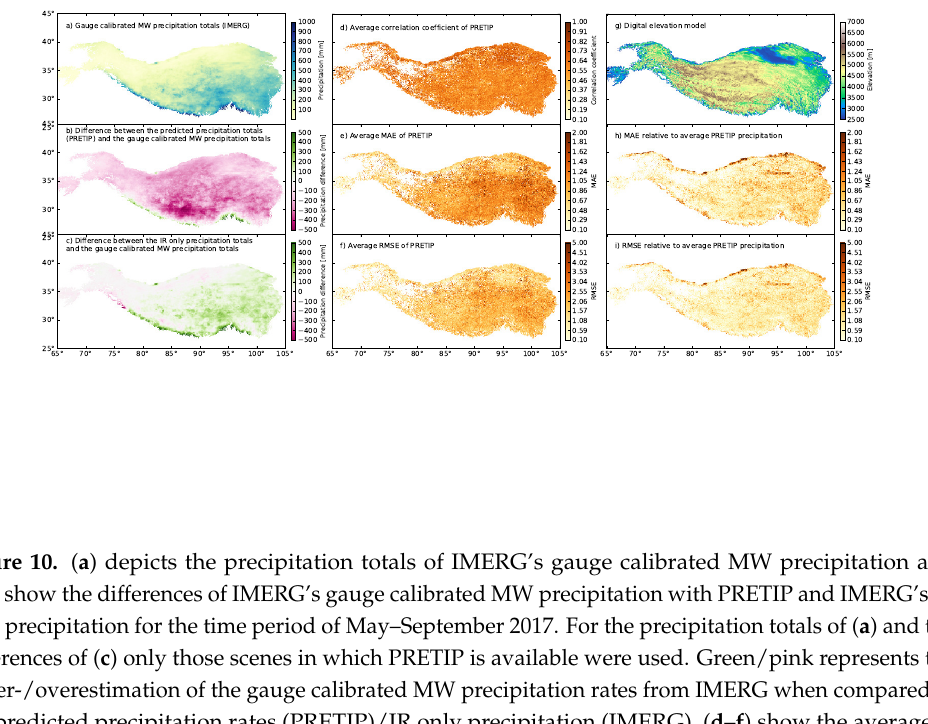
Figure 10. ( a ) depicts the precipitation totals of IMERG’s gauge calibrated MW precipitation and ( b , c ) show the differences of IMERG’s gauge calibrated MW precipitation with PRETIP and IMERG’s IR only precipitation for the time period of May–September 2017. For the precipitation totals of ( a ) and the differences of ( c ) only those scenes in which PRETIP is available were used. Green/pink represents the under-/overestimation of the gauge calibrated MW precipitation rates from IMERG when compared to the predicted precipitation rates (PRETIP)/IR only precipitation (IMERG). ( d – f ) show the average R, MAE, and RMSE of the validation data between PRETIP and the gauge calibrated MW precipitation relative to the number of available PRETIP scenes. ( g ) shows the digital elevation model of the TiP. ( h , i ) illustrate the average MAE and RMSE of the validation between PRETIP and the gauge calibrated MW precipitation relative to the average PRETIP precipitation for the complete time period (May–September